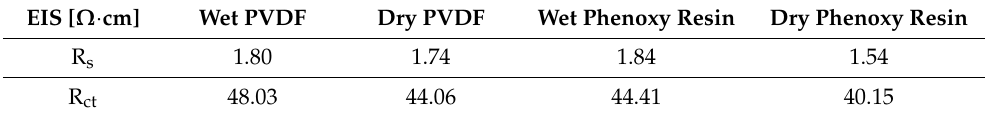
Figure 5. Characterization of electrochemical properties of a half-cell: electrochemical impedance spectroscopic measurement (EIS). Z’: real impedance; - Z’’: imaginary impedance. Table 2. Characterization of electrochemical properties of a half-cell: electrochemical impedance spectroscopic measurement (EIS). R s : resistance of electrolyte; R ct : charge transfer resistance.